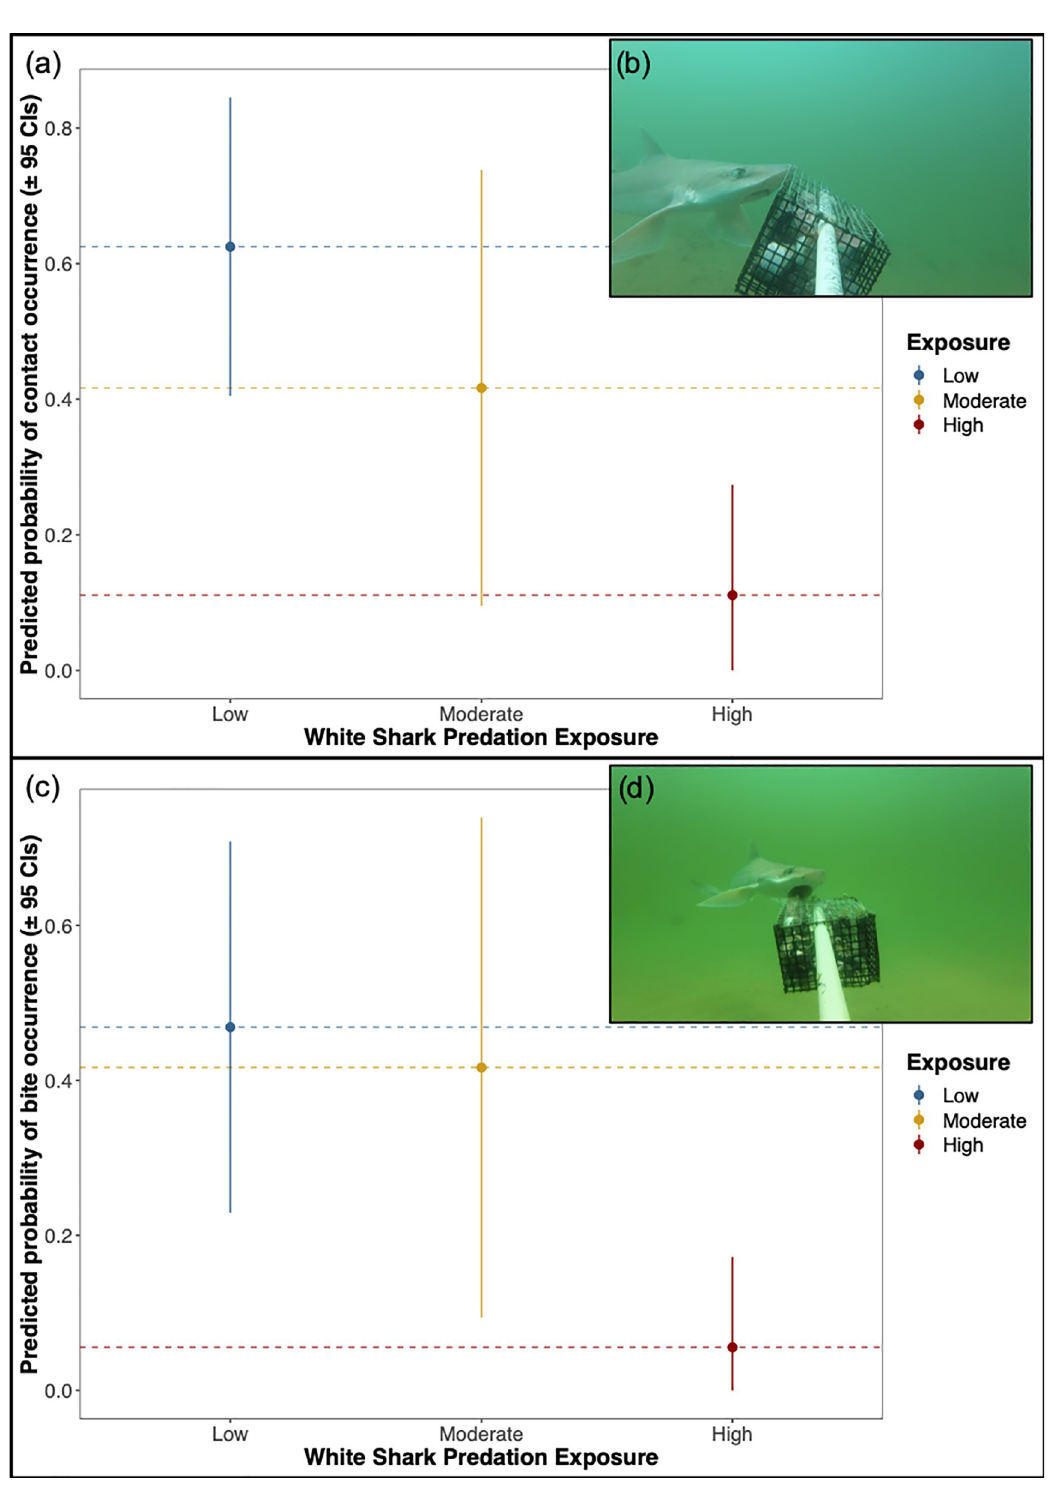
Fig 6. Foraging behaviors of smooth dogfish across a gradient of shark exposure. (a) Predicted occurrence ( ± 95% confidence intervals) of investigatory bait contact by smooth dogfish ( Mustelus canis ) at varying levels of shark exposure; (b) Still image from BRUV deployment depicting investigatory contact by smooth dogfish; (c) Predicted occurrence ( ± 95% confidence intervals) of bait bites by smooth dogfish; (d) Still image from BRUV deployment depicting bait bite by smooth dogfish. Sites were pooled for plotting given the range of smooth dogfish within the study area (smooth dogfish are uncommon at Race Point).